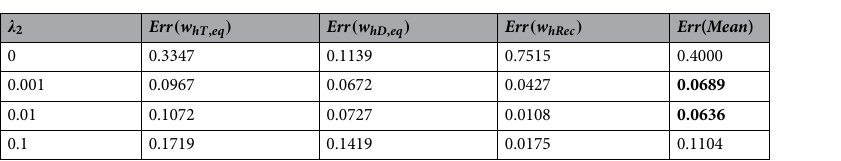
Table 2. Error values for Physical Model-4 with different (cid:31) 2 values. Err ( w hT , eq ) , Err ( w hD , eq ) and Err ( w hRec ) are the error values in the trapping equivalent, detrapping equivalent and recombination coefficients of the holes respectively. Err ( Mean ) is the arithmetic mean each of these error values. Hole injections are at voxel 24, 27 and 30. Significant values are in